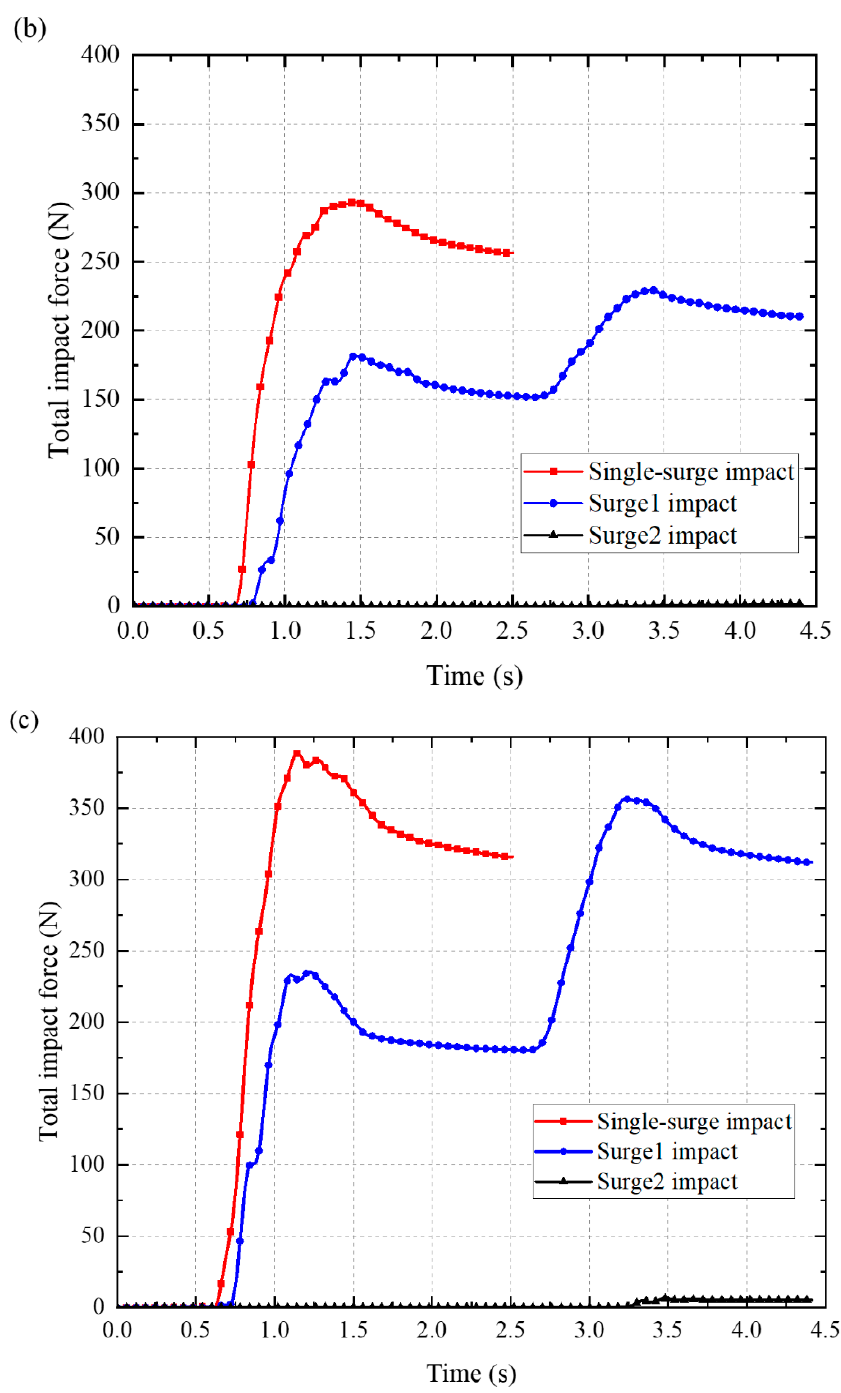
Figure 6. Typical time–history curve of the impact force on a rigid barrier showing the evolution of the single-surge impact and multiple-surge impact (surge1 and surge2). The slope angle is ( a ) 30°, ( b ) 35° and ( c ) 40°. The total surge volume is 39.6 L.